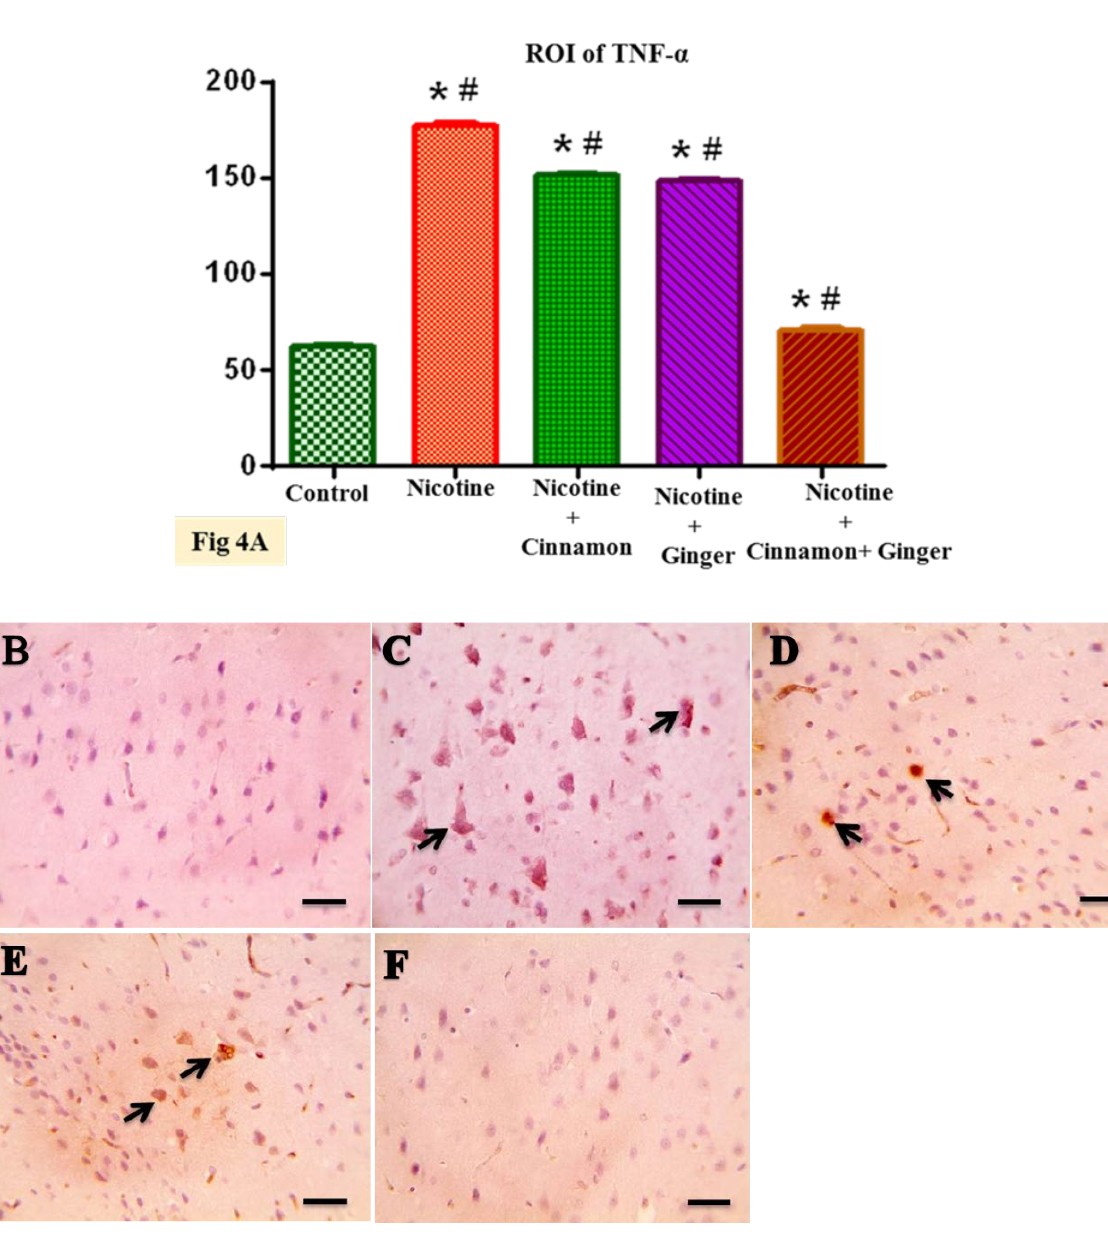
Figure 4. The expression of TNF- α by immunostaining in different groups. ( A ) Graphs of ROI of the expression of TNF- α in different groups. ( B ) Brain specimens showing normal expression of TNF- α neurons of prefrontal cortex (control group), ( C ) marked strong positive reaction of TNF- α in prefrontal cortex neurons (black arrows) (nicotine group), ( D , E ) moderate expression of TNF- α in prefrontal cortex neurons (black arrows) (nicotine+ cinnamon oil and nicotine + ginger groups), and ( F ) negative expression of TNF- α in prefrontal cortex neurons (nicotine+ cinnamon oil +ginger oil group). * Significantly different from the control group; # significantly different from other group p value = 0.05. X: 400 bar 50.